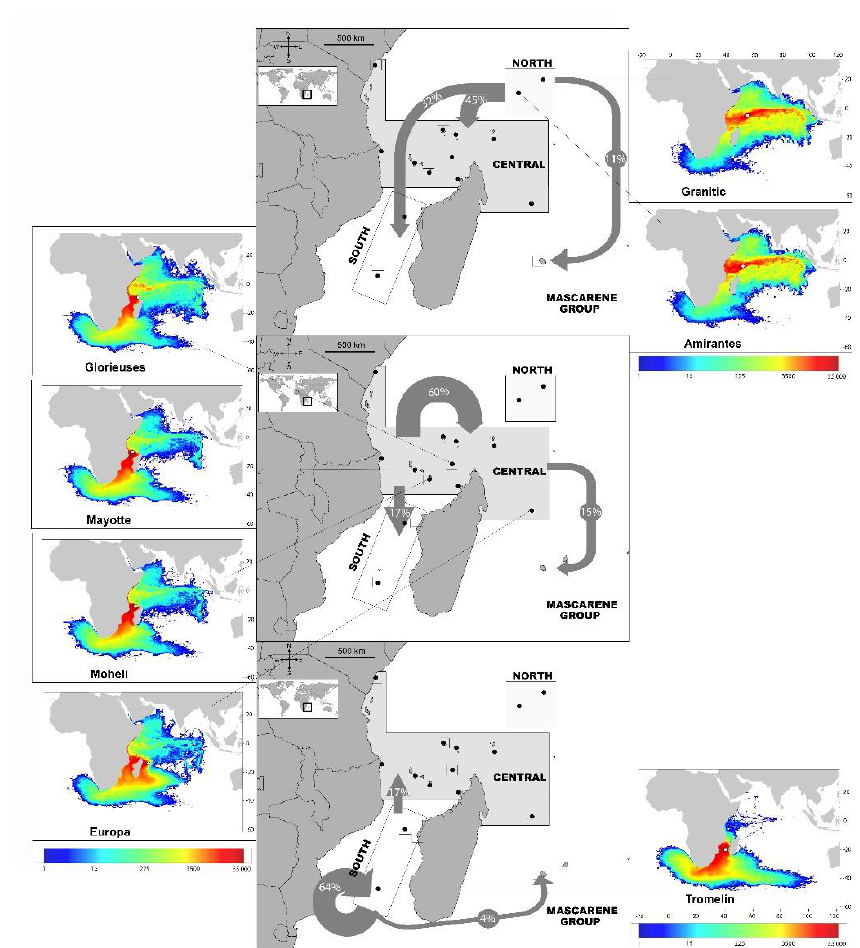
Figure 2. Dispersal from rookeries. Small maps show the density distributions of juveniles emerging from the seven simulated nesting areas (Colors indicate the number of particles). The three central maps show the proportional distribution of juvenile turtles from each Area (North, Central and South) based on Bayesian “rookery-centric” estimates using the many to many mixed stock analysis.